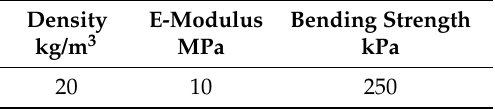
Table 2. Properties expanded polystyrene (EPS) 200 [31] .